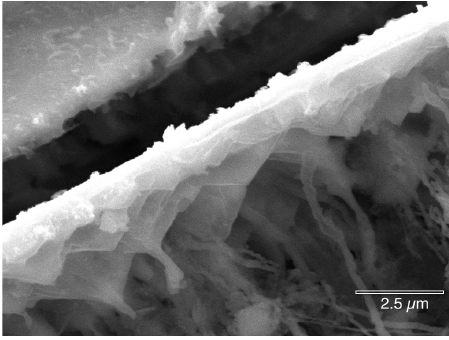
Figure 11. Microbial filaments attached to the copper inside a pit (HMDS